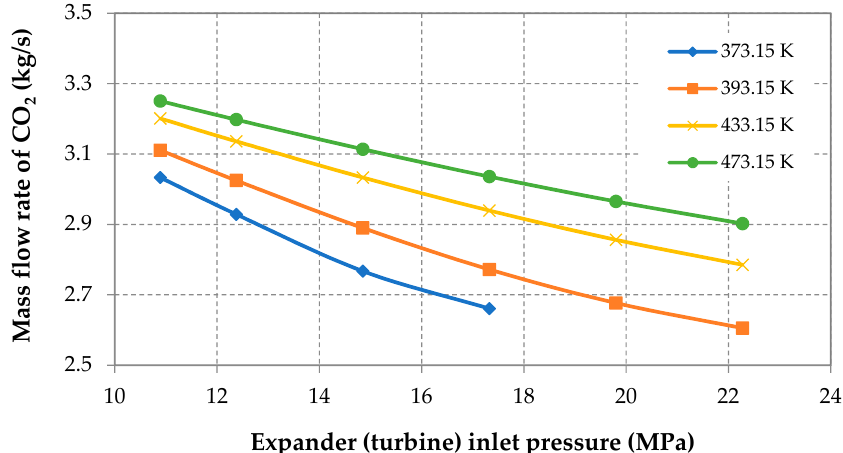
Figure 6. Relationship between turbine inlet temperature and percent of waste heat transferred to CO 2 for the different exhaust gas temperatures at the heat exchanger outlet.